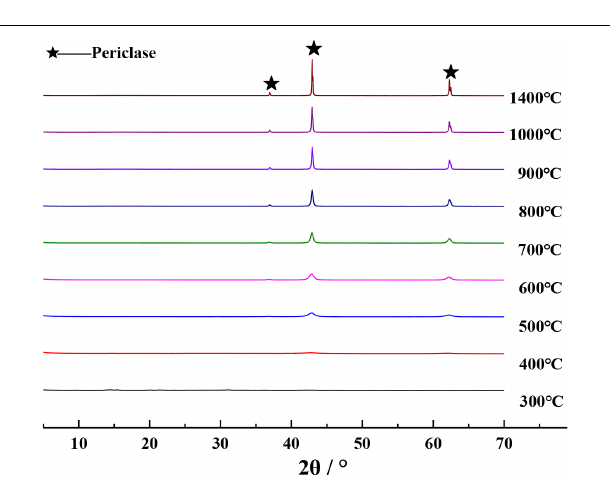
FIGURE 3 | XRD patterns of calcined products of Mg(OH) 2 · 3MgCO 3 · 3H 2 O at different temperatures.